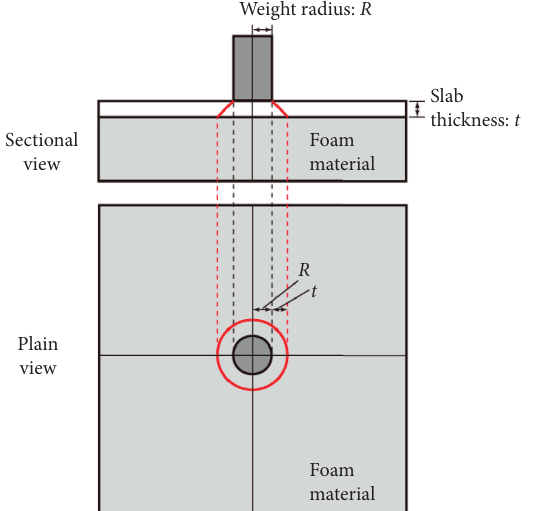
Figure 16: Conception diagram of the punching shear fracture of the core slab (in the case that diagonal tension cracking the angle of the core slab is 45 degrees).